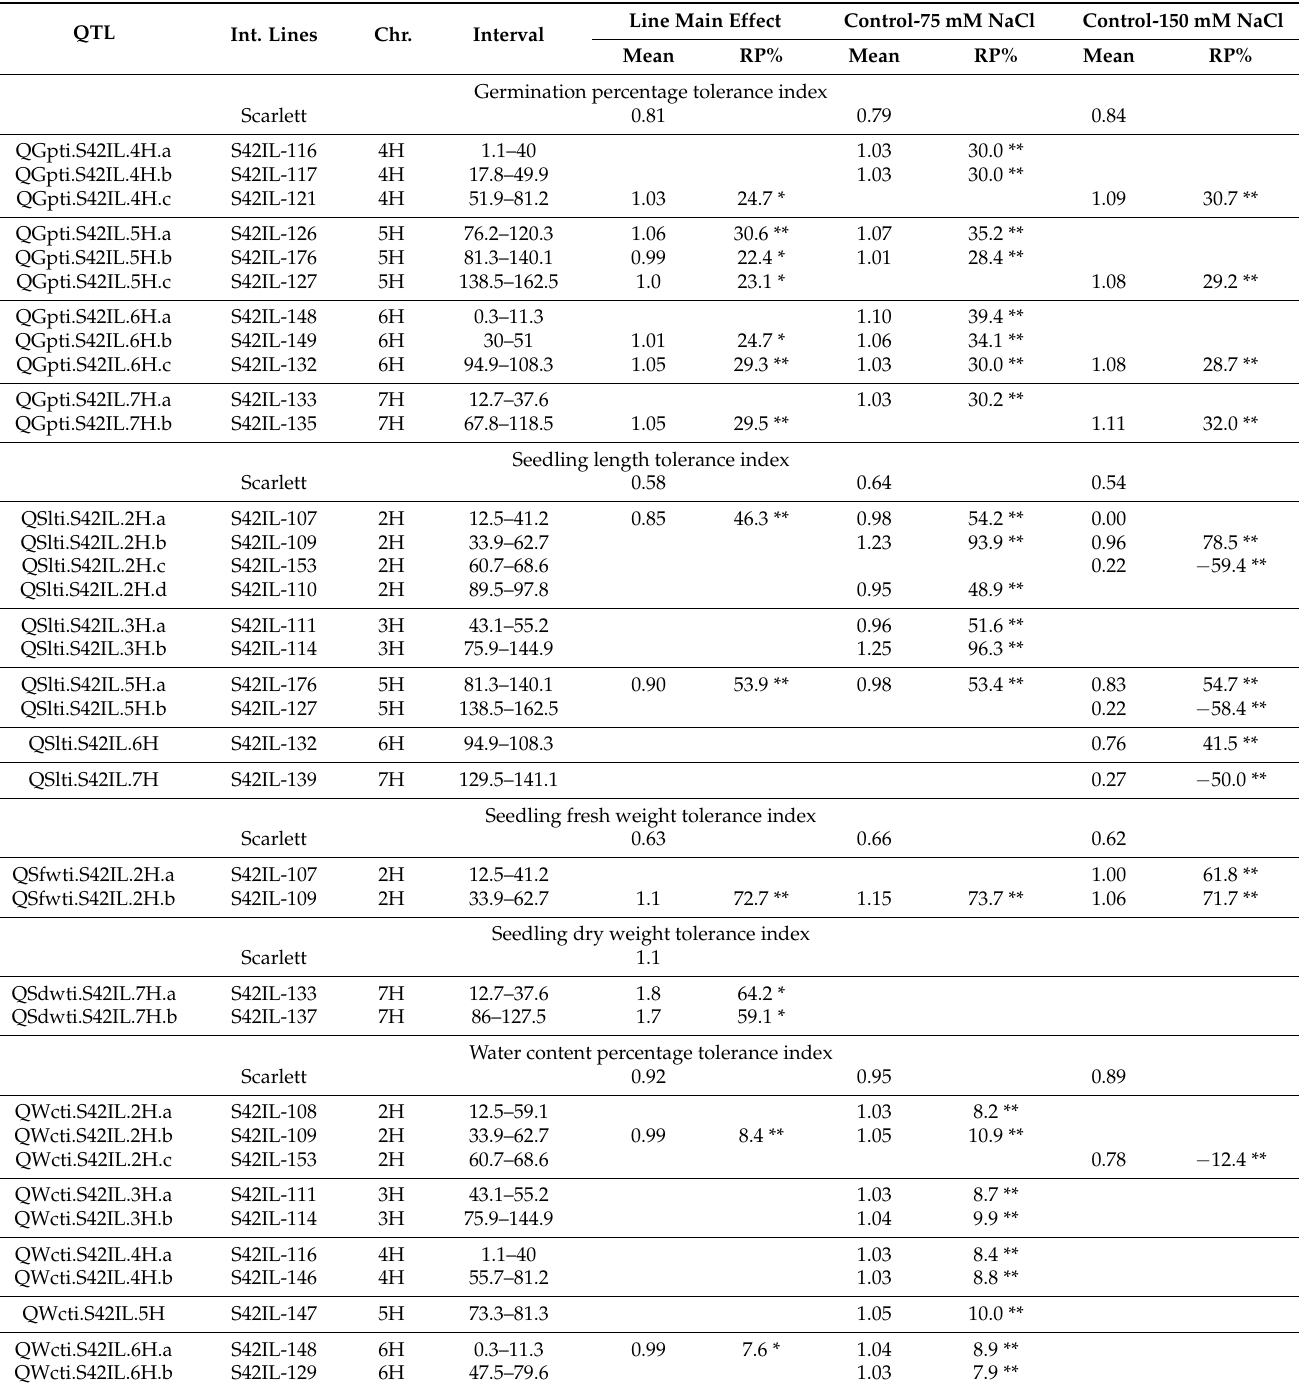
Table 5. Identification of putative QTL associated with salinity tolerance indices at germination and seedling stages as line main effect and line by treatment